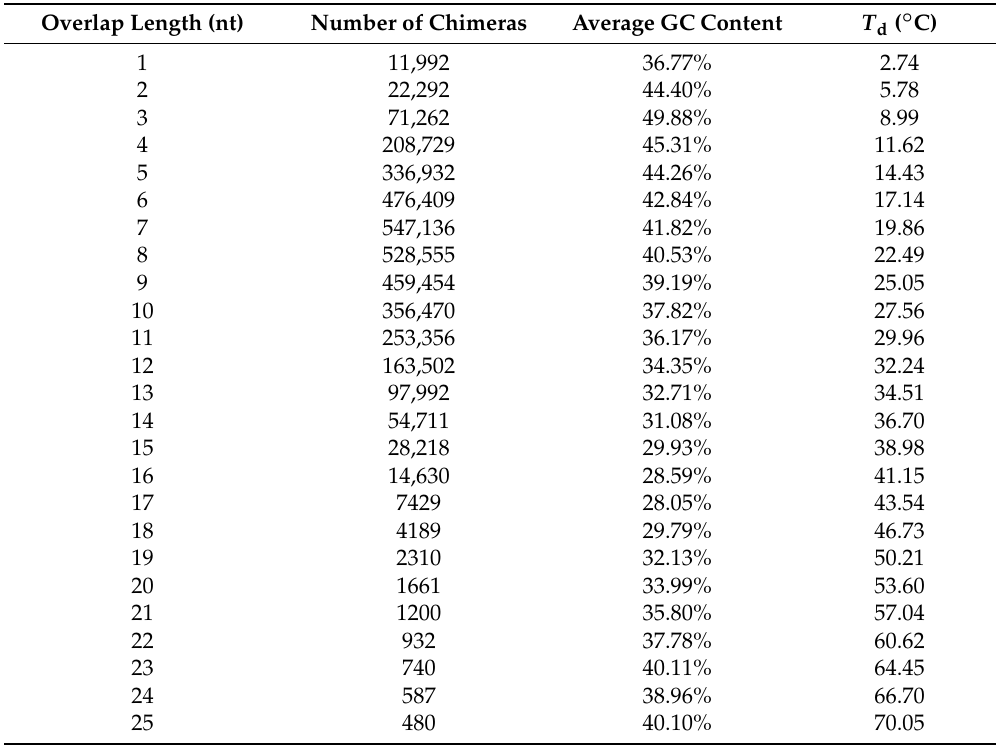
Table 1. Average GC content and estimation denaturation temperature of overlaps in chimeras.